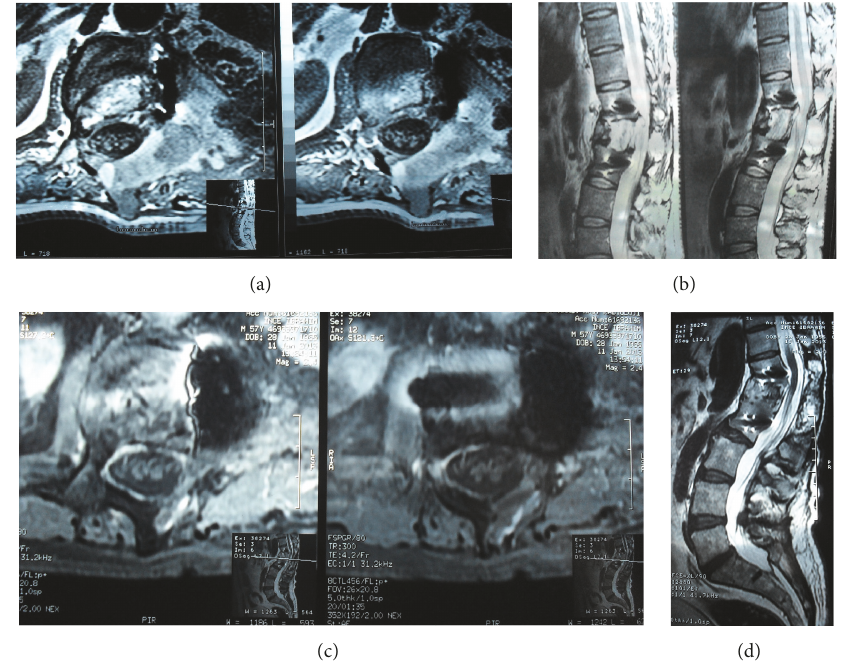
Figure 8: (a, b) MRI, axial T 1 WI and sagittal T 2 WI: the hemangioma is totally removed and the spinal cord is decompressed. (c, d) At the sixteenth year follow-up MRI, axial T 1 WI with gadolinium and sagittal T 2 WI show no recurrence.